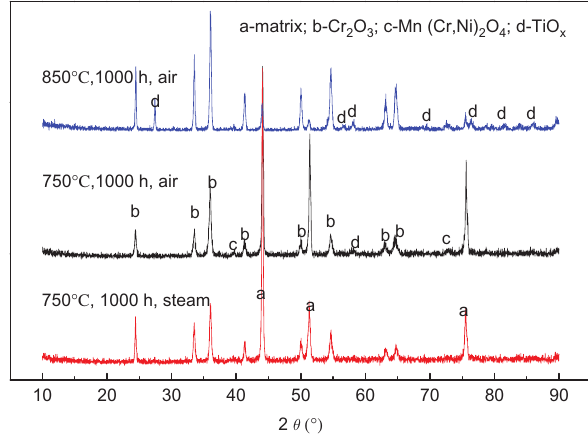
Figure 2: XRD patterns of Inconel 740H after oxidation at three different